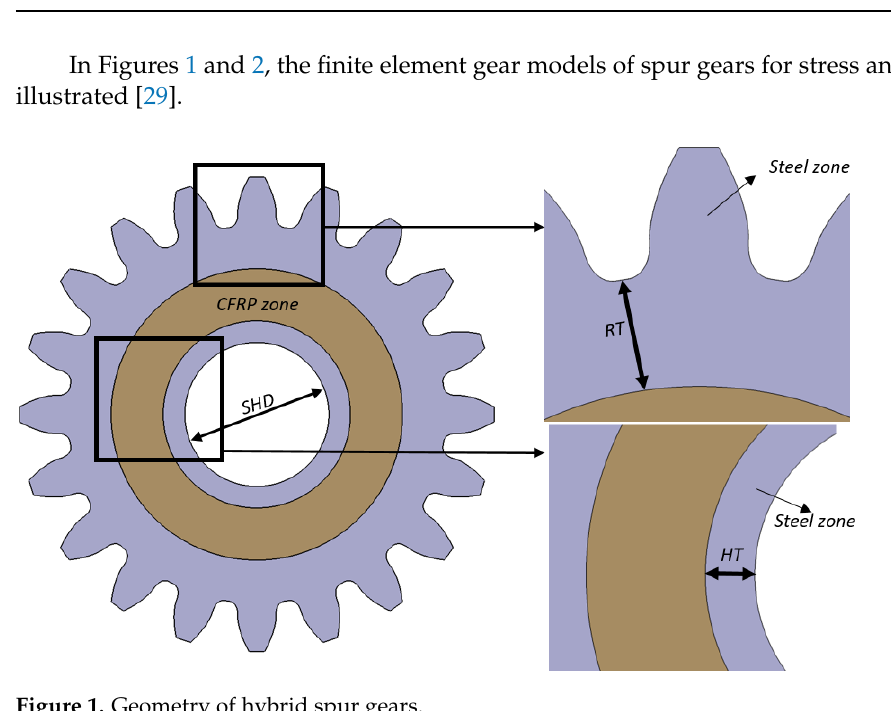
Figure 1. Geometry of hybrid spur gears.